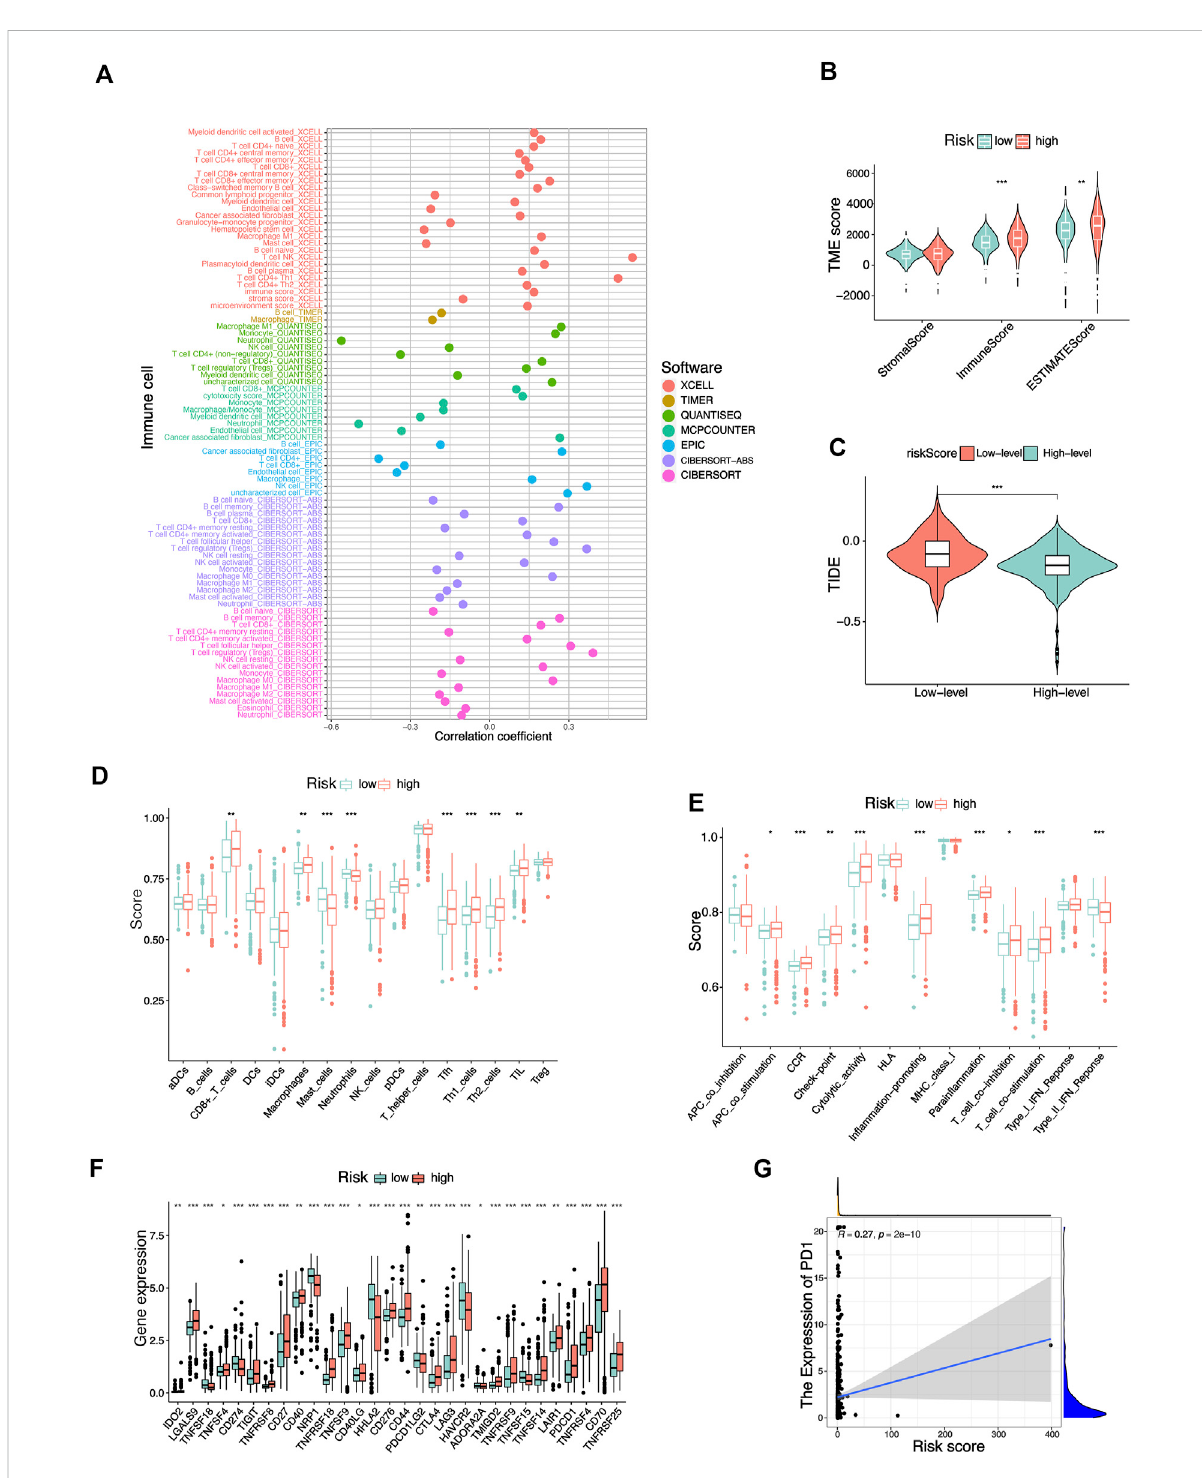
FIGURE 9 Potential effects of risk signatures on tumor immune microenvironment in KIRC patients. (A) The correlation between different immune cells andriskscoreswasanalyzedbasedonmultiplealgorithms. (B) DifferencesinStromalScore,ImmuneScore,andESTIMATEScoreinKIRCpatientswith different risk groups (ESTIMATE algorithms). (C) Differences in immunotherapy sensitivity among different risk groups (TIDE algorithms). Differences inenrichmentscoresof16immunecells (D) and13immune-relatedpathways (E) indifferentriskgroups. (F) Differentialexpressionofcommon immune-checkpoints in different risk groups. (G) Correlation between risk scores and PD1 expression in KIRC patients. *p < 0.05, **p < 0.01, ***p <